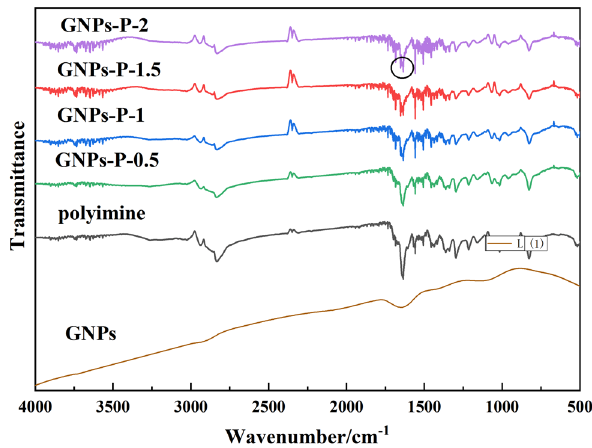
Figure 1: FTIR spectra of GNPs, polyimine, and di ff erent GNPs - P composites.